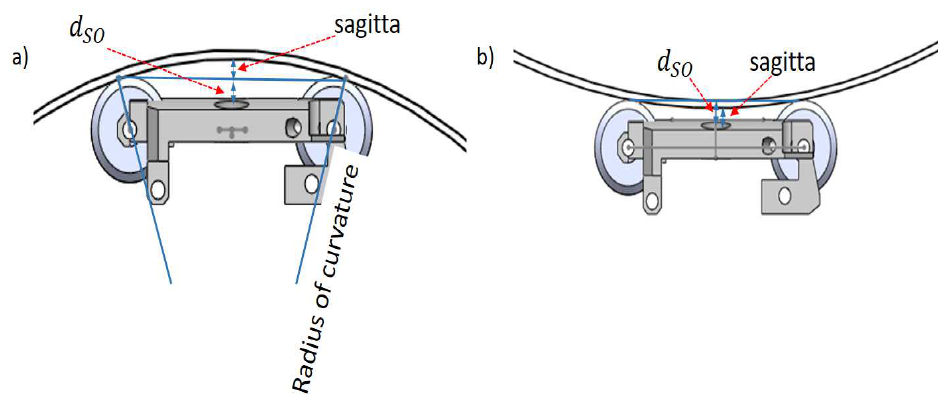
Figure 14. Longitudinal section plane. ( a ) sensor carrier on a concave surface; ( b ) sensor carrier on a convex surface.